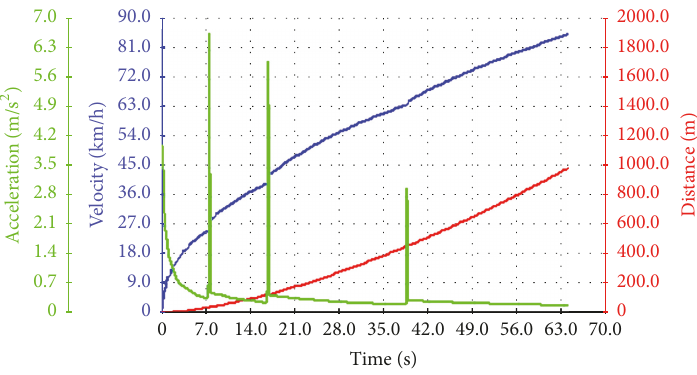
Figure 5: Start continuous shift acceleration